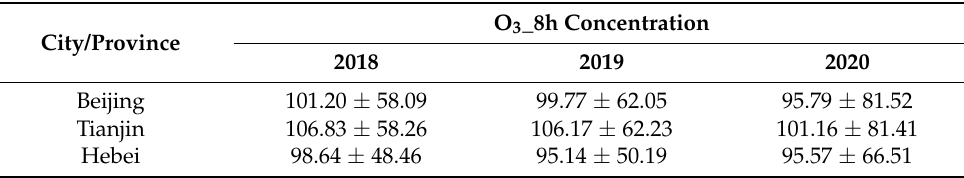
Figure 3. Trend of O 3 _8h concentration from 2018 to 2020 in Jing-Jin-Ji region in China. Table 1. Annual averaged and standard deviation of ozone concentration from 2018 to 2020 in Jing-Jin-Ji region (μg/m³).